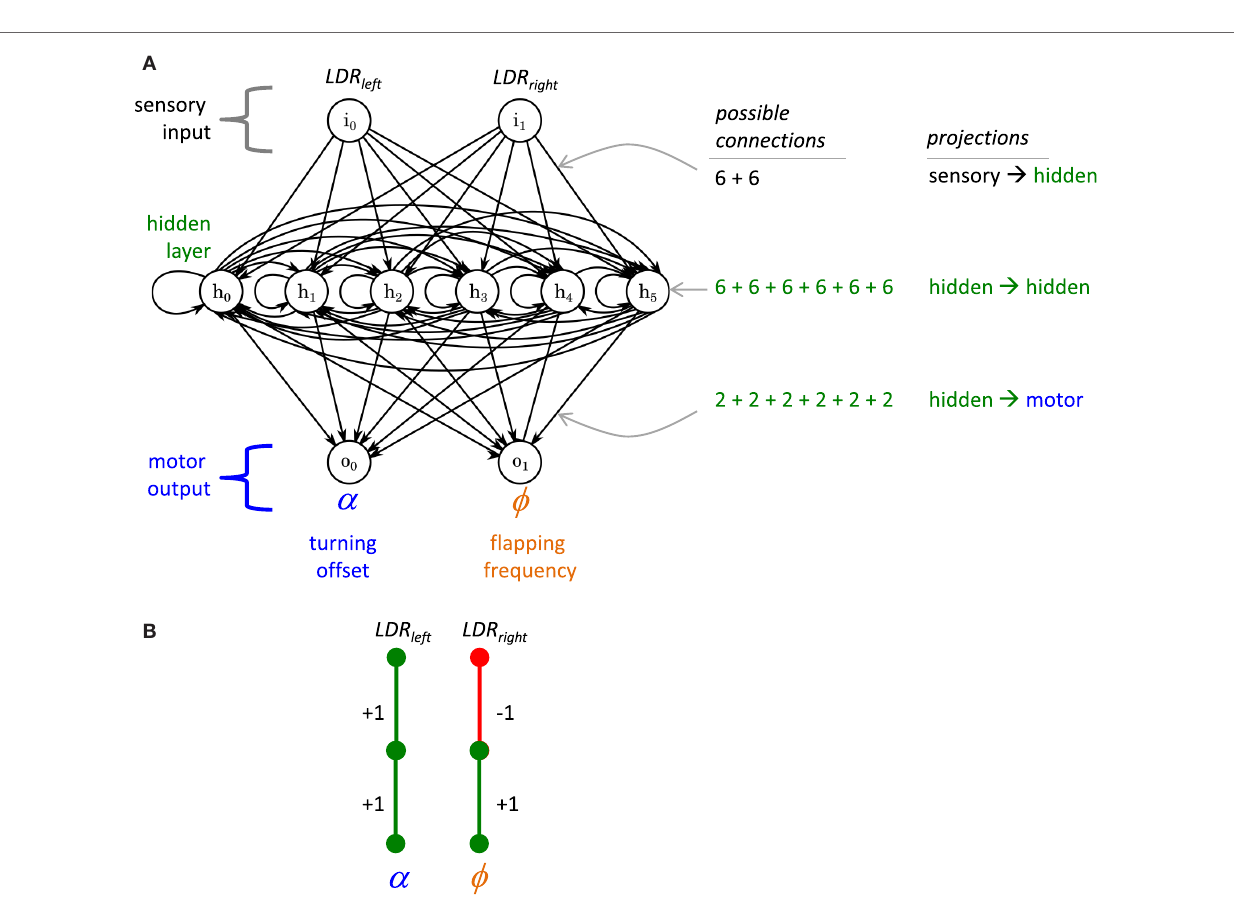
FigUre 1 | Framework for Tadro’s artificial neural network (ann) . (a) The basic framework is a 2 × 6 × 2 recurrent network instantiated in software. Two inputs are the light-dependent resistors (LDRs), left and right, mounted on the perimeter of the hull. Each input may have up to six connections to the nodes of the hidden layer. Each of the six nodes of the hidden layer may have up to six recurrent connections, one with itself and five with other hidden layer nodes (represented by the horizontal line connecting the nodes). The nodes of the hidden layer may have up to two connections to the nodes of the motor output layer. The weights of the connections may be − 1, 0, or 1, inhibitory, missing, or excitatory, respectively. At each time step, each node sums inputs and generates a single activation. (B) Engineered network. This is the simplest network that solves the task of phototaxis in this environment using both sensors and both motor outputs. It has a modularity, Q , value of 0.5, a sparsity, S , value of 0.93 for the whole ANN, and a fitness value, ω , of 52.6 × 10 6 . Since this engineered solution represents a local optimum in the Q – S fitness landscape, we expect a starting population of randomly generated networks to evolve toward this